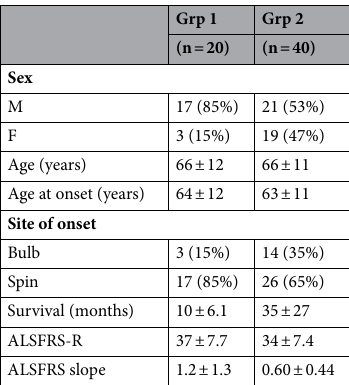
Table 4. Summary data of ALS